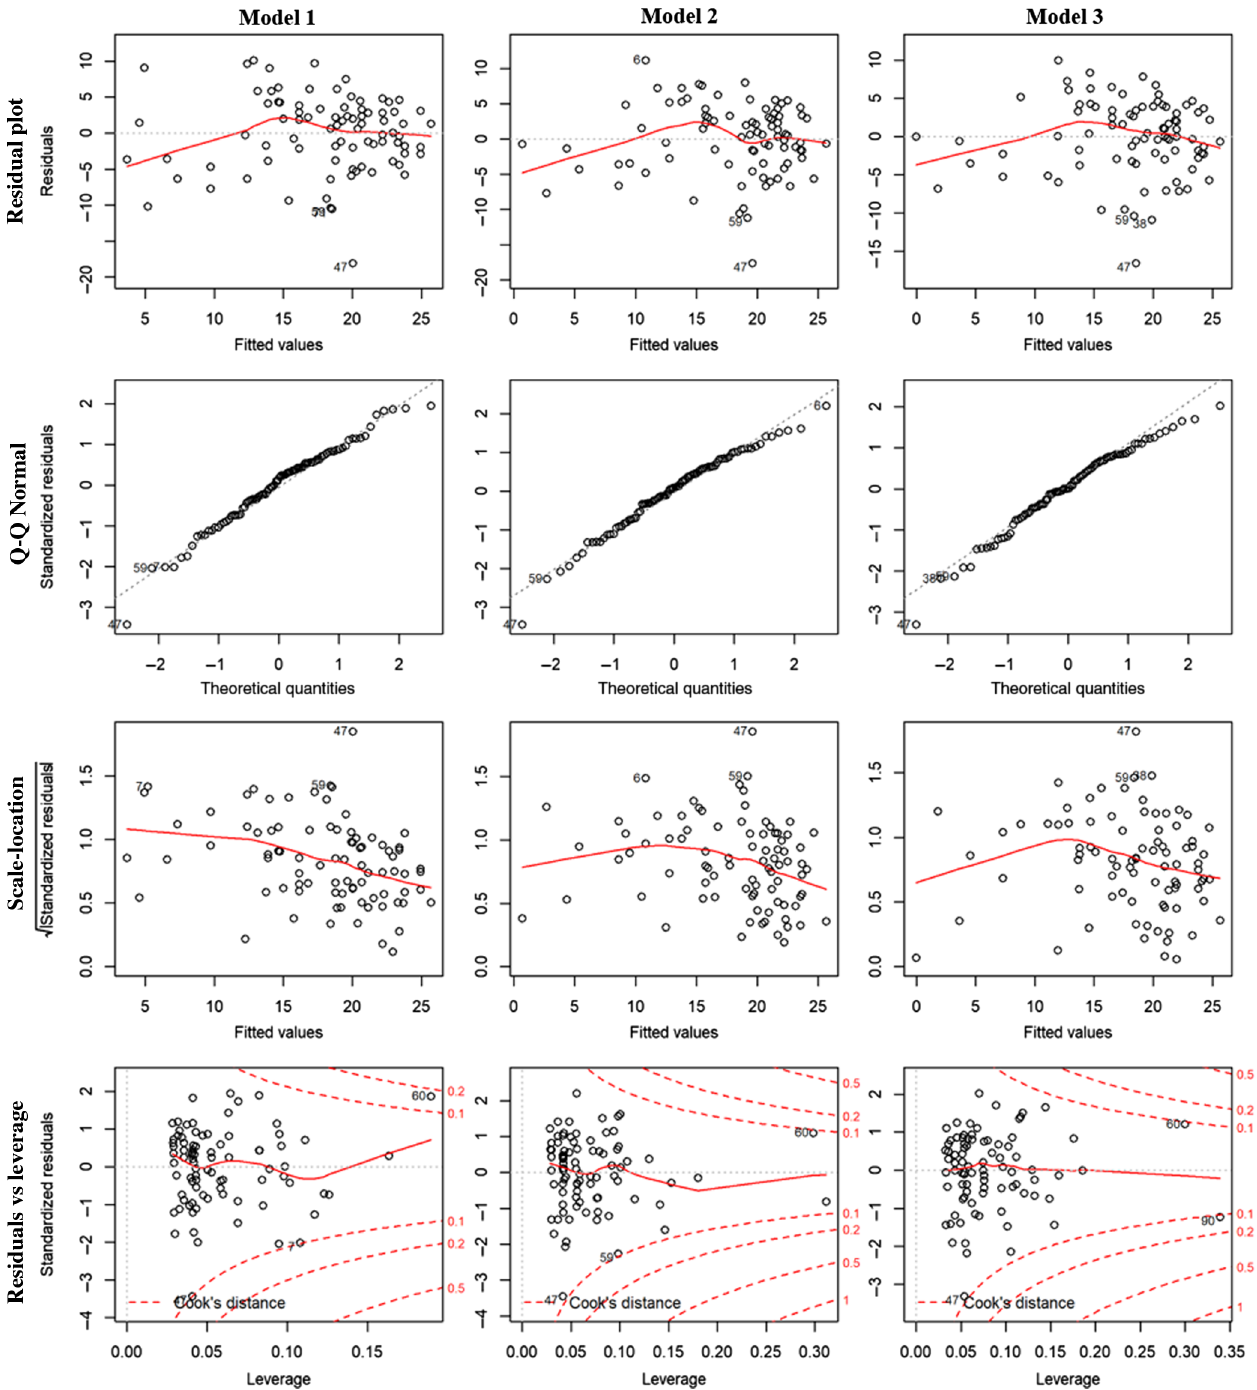
FIG. 4. Model diagnostic plots using E-CLASS scores of students in semester